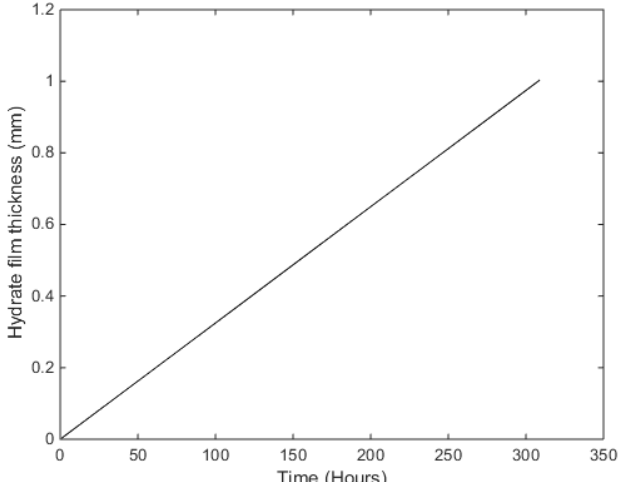
Figure 15. Calculated CO 2 hydrate film thickness as a function of time for a liquid side diffusivity in Equation (10) equal to D liq = 10 −08 m 2 /s.